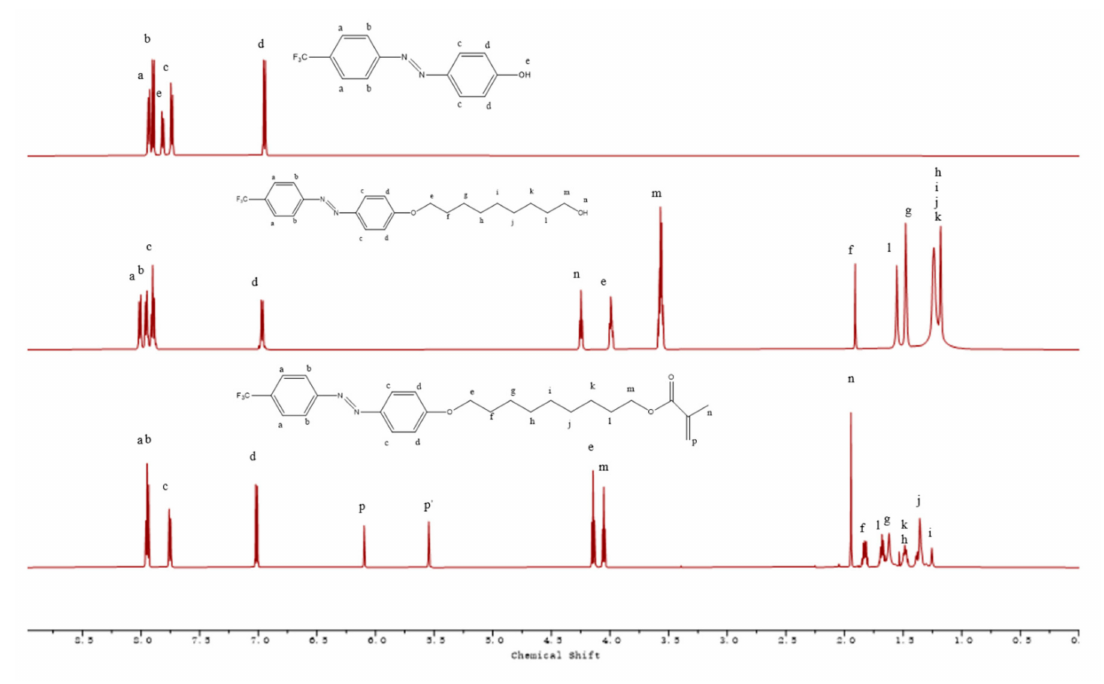
Figure 3. 1 H NMR spectra of FAZOH, FAZ9OH, and FAZO.